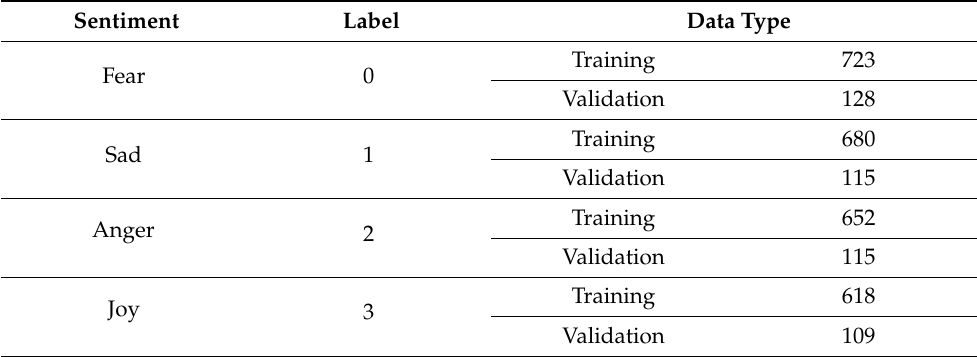
Figure 2. Tweets’ token length outcome. Table 2. Demographic representation of tweets